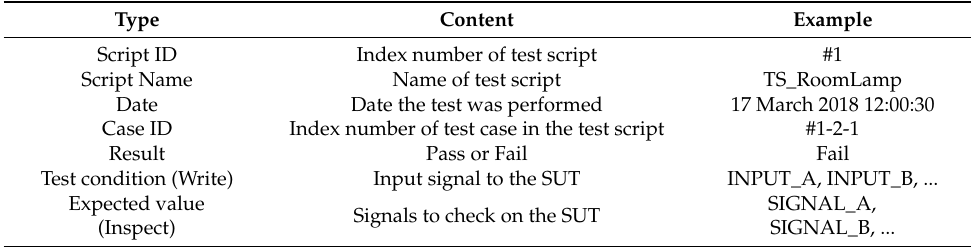
Table 1. Example of test information.